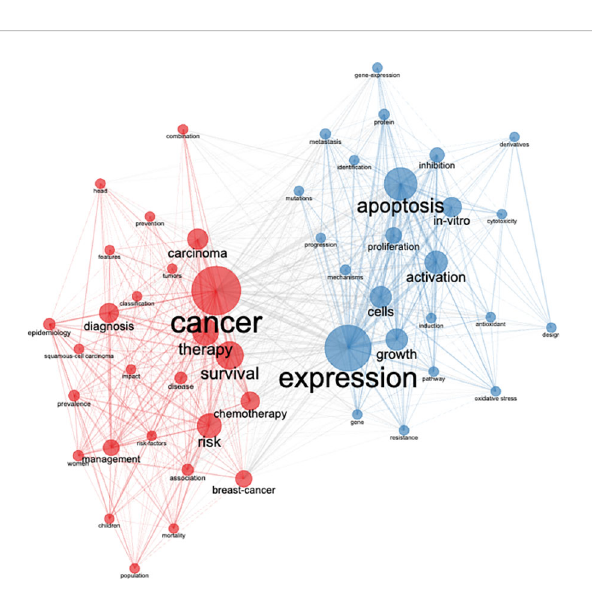
FIGURE 9 Co-occurrence network of most frequently used author keywords on cancer research in FCS in the MENA region from 2000 to 2021. The rectangle size re fl ects the total number of highly cited articles, while the color and thickness of the lines re fl ect the link clustering and strength,